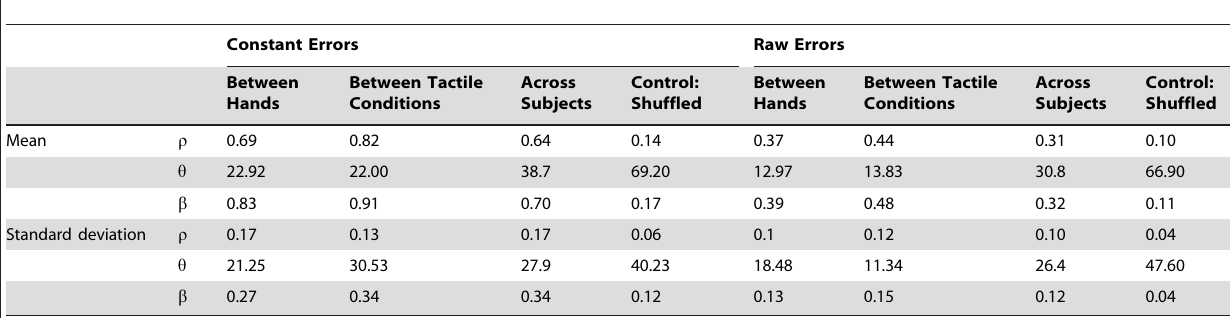
Table 2. Test of Similarity Across Hands, Conditions, and Subjects: Resulting r , h , b from the vector field correlation analysis of the raw and constant errors.